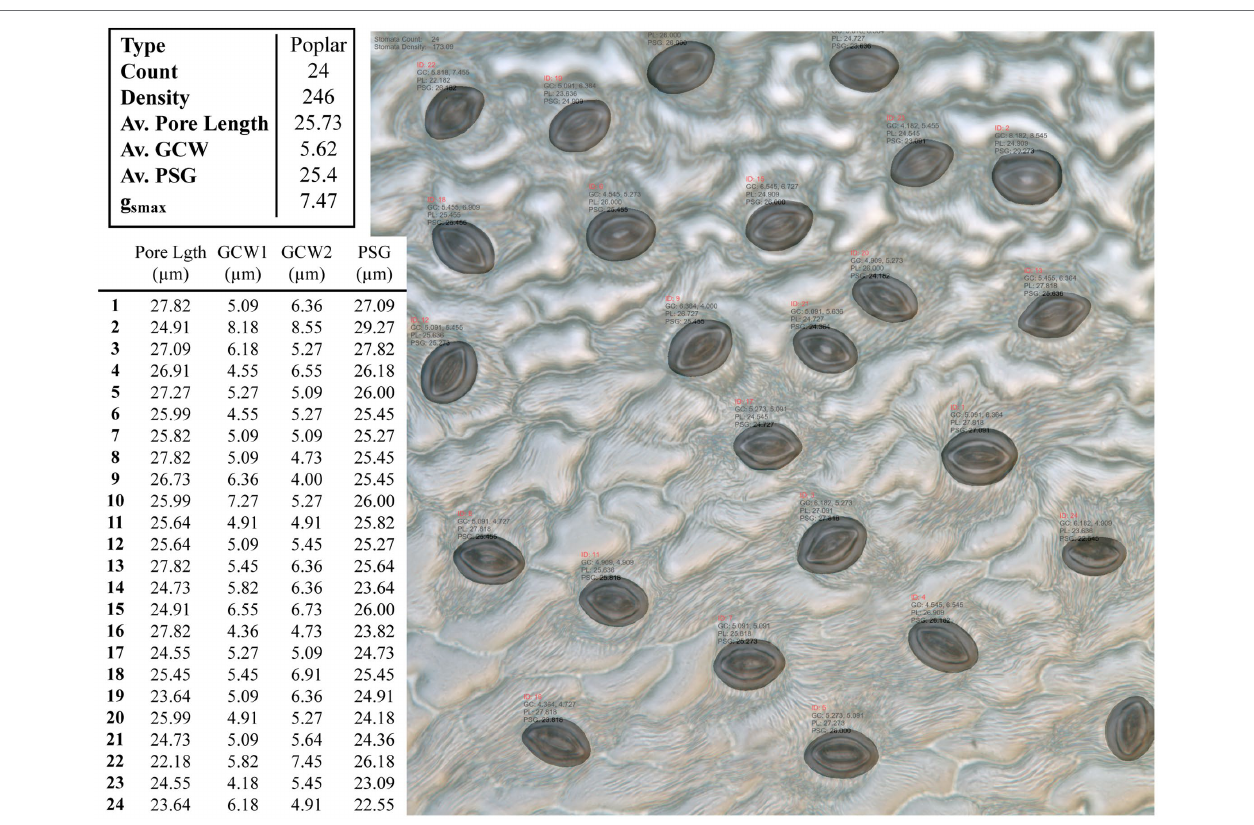
FIGURE 4 | Example output from the CNN model applied to an unseen poplar image. Summary results for the whole images are given in the top table, whilst the measurements for individual stomata are given in the bottom, where GCW refers to guard cell width and PSG refers to peristomatal groove distance.